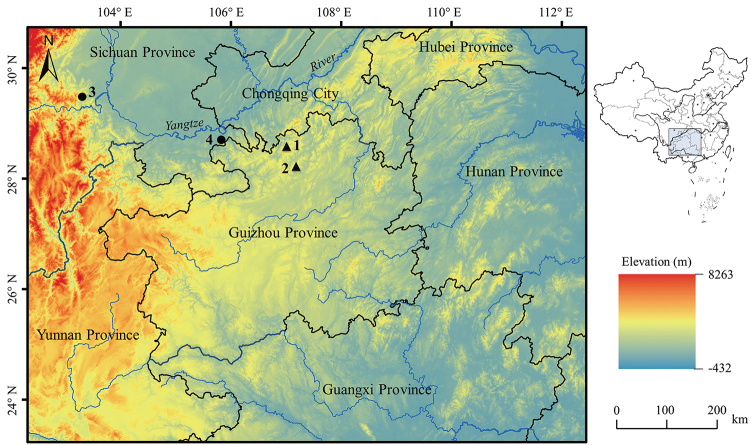
Type locality of Nidirana
yeae sp. nov. and sampling localities of N.
daunchina. 1, the type locality of Nidirana
yeae sp. nov., Huanglian town, Tongzi County, Guizhou Province, China; 2, Kuankuoshui National Nature Reserve, Suiyang County, Guizhou Province, China as the potential distribution area deduced from Wu et al. (1986); 3, the type locality of N.
daunchina, E’mei Mountain, Sichuan Province, China; 4, Hejiang County, Sichuan Province, China.